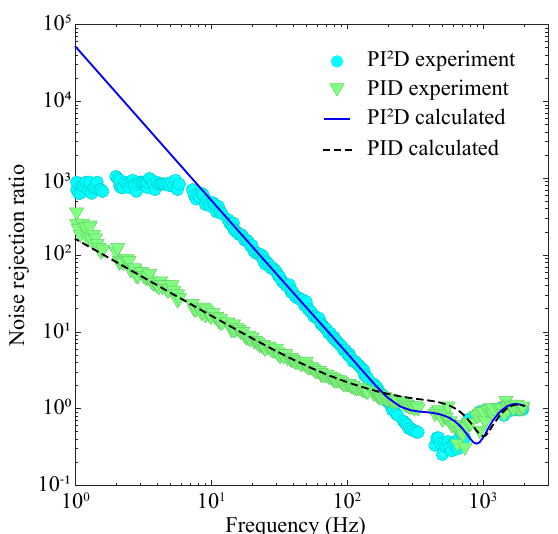
Figure 3. Noise rejection ratio of the active magnetic-field stabilization system. The green triangles and light blue circles show the experimentally measured noise rejection ratios using a PID module and a PI 2 D module, respectively. The calculated noise rejection ratios using a PID module and a PI 2 D module are shown by the black dashed line and dark blue solid line,